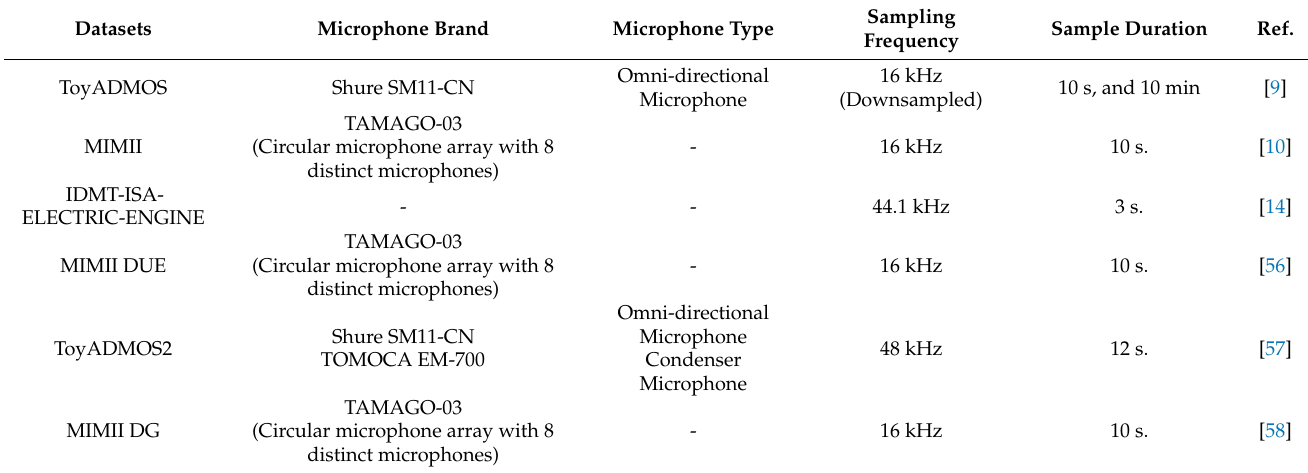
Table 9. Exemplar acoustic measurement devices and sampling parameters.